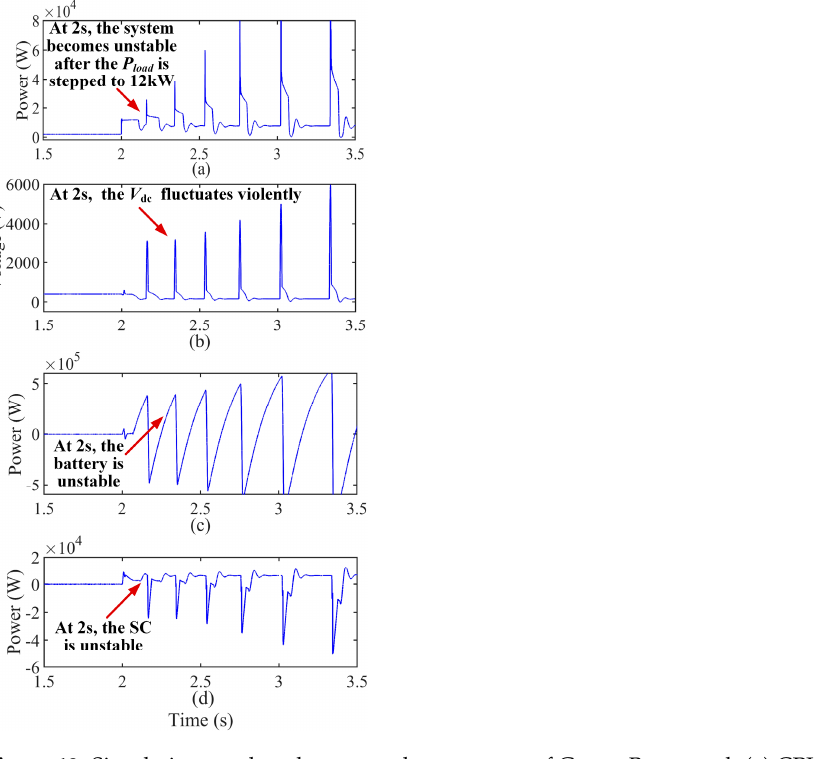
Figure 13. Simulation results when control parameters of Group B are used. ( a ) CPL power, ( b ) DC bus voltage, ( c ) battery power and ( d ) SC power.